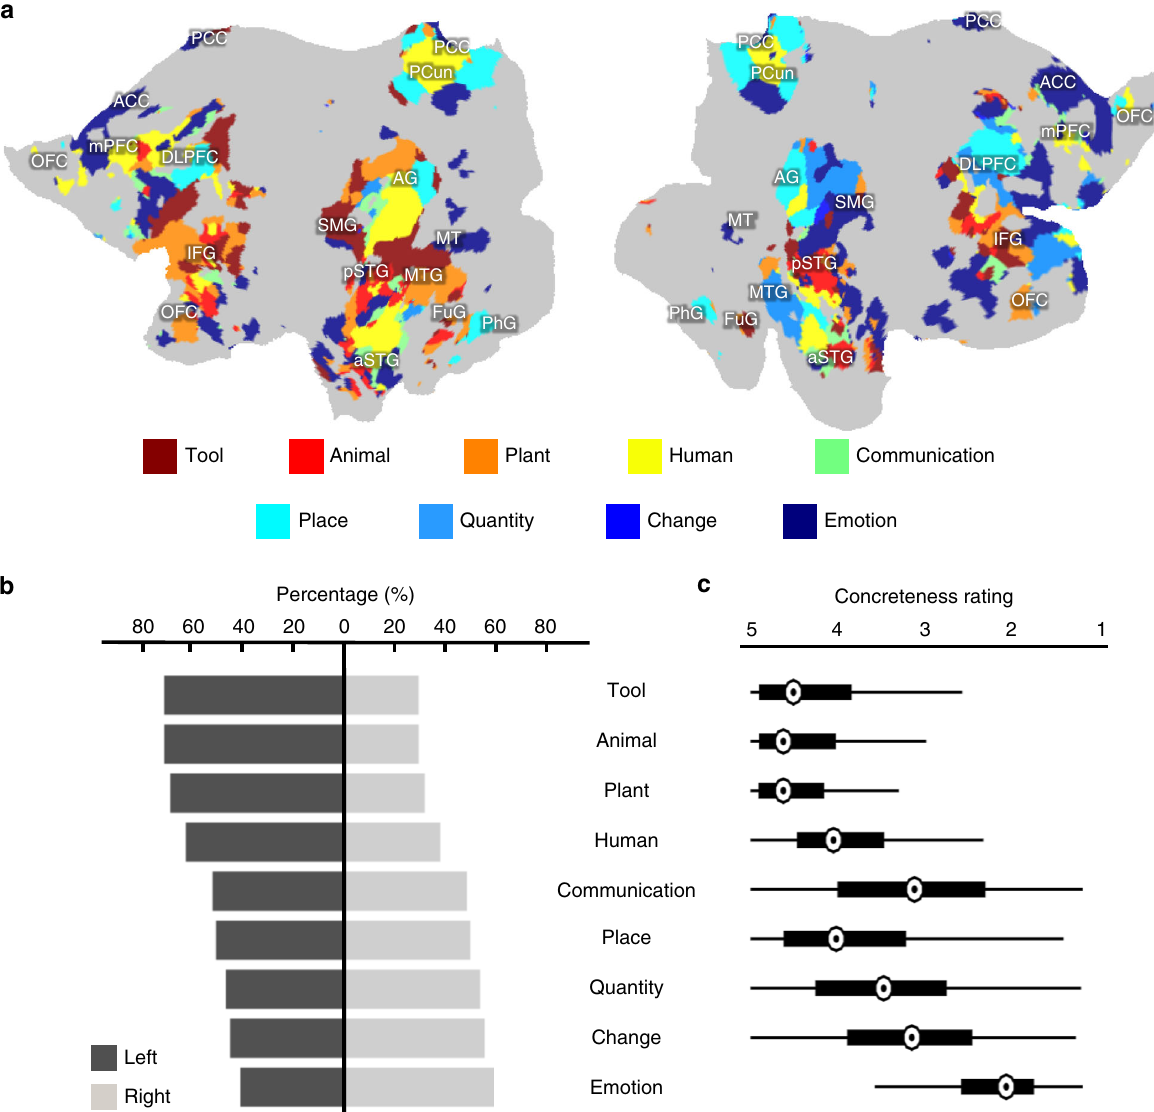
Fig. 5 Cortical representation of semantic category. a Category-labeled parcellation based on voxel-wise selectivity using a “ winners take all ” strategy. b Cortical lateralization of categorical representations. For each category, the percentage value was calculated by counting the number of voxels on each hemisphere that represented the given category. The number of word samples in each of the nine categories is: tool (200), animal (734), plant (387), human (808), communication (2027), place (814), quantity (958), change (3417), and emotion (504). c The concreteness rating of words in each category. The maximum value of the concreteness rating is 5.00 and the minima value is 1.25. In this box plot, the central mark indicates the median, and the box edges indicate the 25th and 75th percentiles, respectively. The maximum whisker length is